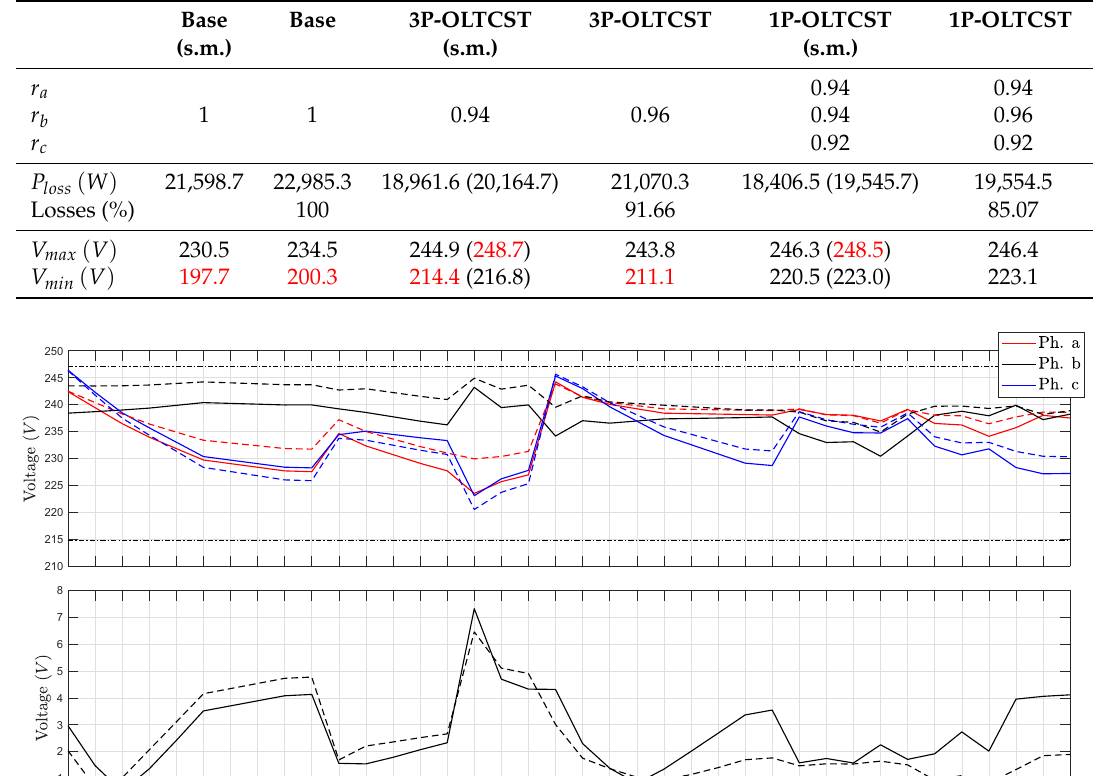
Table 4. Simulation results when the primitive impedance matrices or the simplified model (s.m.) are considered in the system line modeling.